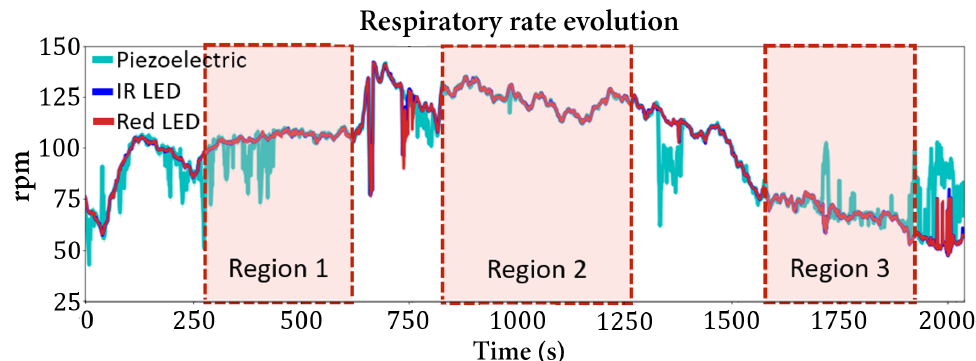
Figure 9. Respiratory rate evolution (Mouse 1) through sevoflurane concentrations changes. The high- lighted regions represent moments where the anesthetic concentration did not change: Region 1— stable zone at 2% of sevoflurane; Region 2—stable zone at 1.5% of sevoflurane; Region 3—stable zone at 4% of sevoflurane. Table 1. Respiratory rate (RR) values for the several concentrations of sevoflurane. P: value obtained with the piezoelectric sensor data; IR: value obtained with the IR LED data; Red: value obtained with the Red LED data. Mouse Sevoflurane (%) RR ± ∆ RR